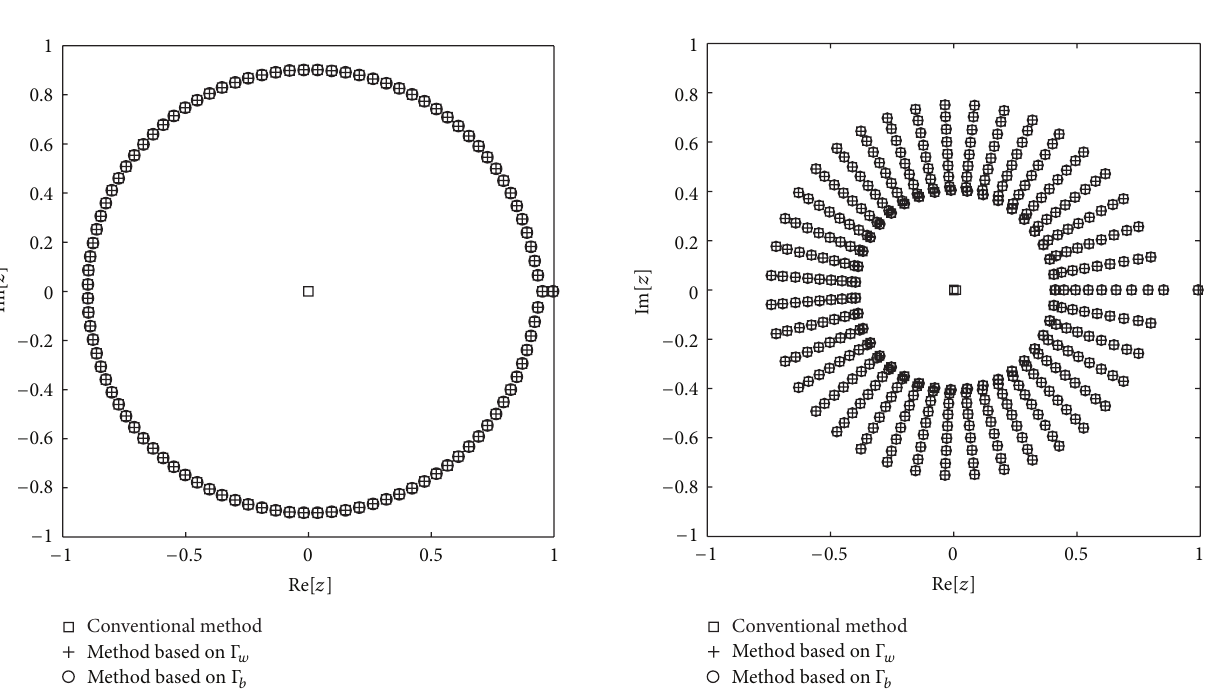
Figure 4: Eigenvalues for two-dimensional airfoil when increasing the number of element panels.